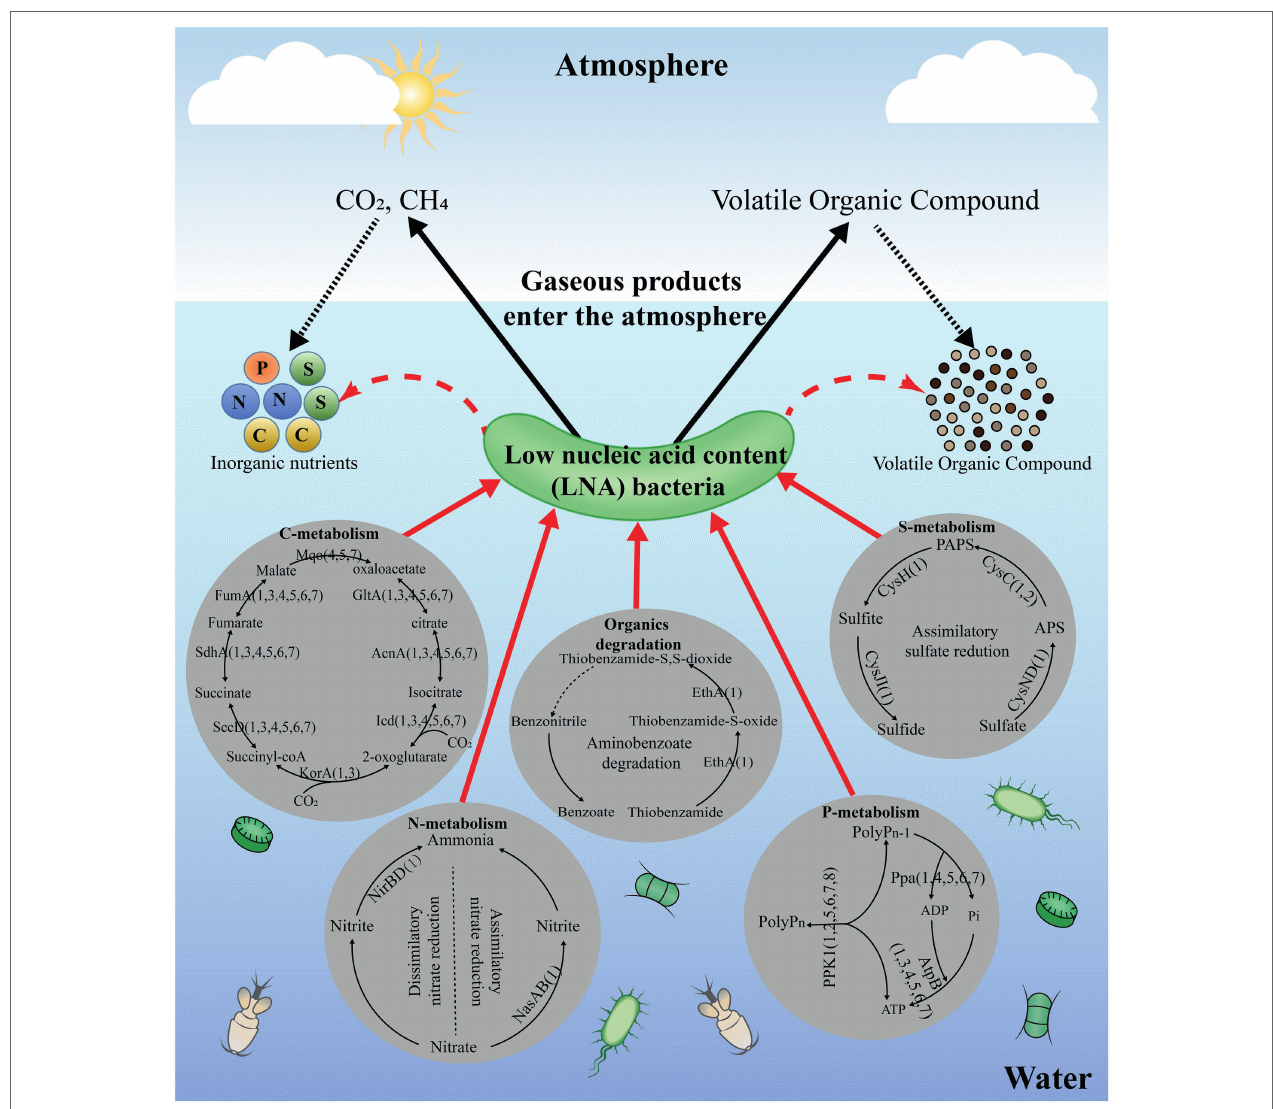
FIGURE 3 | The potential metabolic functions of LNA bacteria and ultramicrobacteria in the aquatic environments. The enzymes in the figure means that can be annotated in pathways of the strains in KEGG and the number in the figure means the strains. All data used for the analysis were obtained from NCBI database; 1: Sphingopyxis alaskensis RB2256; 2: Candidatus Pelagibacter ubique HTCC1062; 3: Candidatus Fonsibacter ubiquis LSUCC0530; 4: Aurantimicrobium minutum KNCT; 5: Aquiluna borgnonia 15G-AUS-rotT; 6: Candidatus Planktophila rubra IMCC25003; 7: Aurantimicrobium photophilum